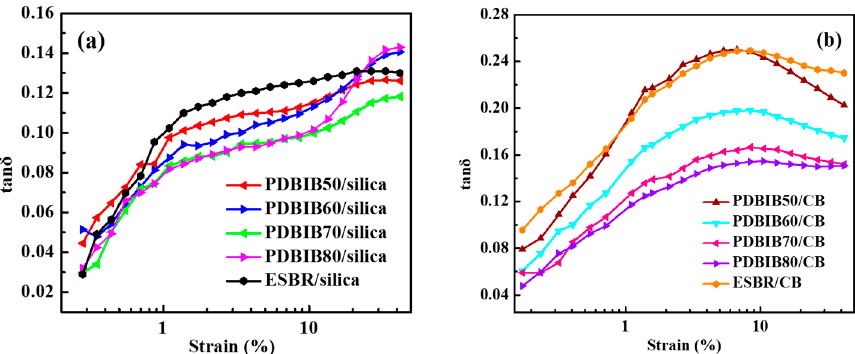
Figure 8. Strain dependence of loss tangent (tan δ ) ( a ) PDBIB / silica and ESBR / silica, ( b ) PDBIB / CB and ESBR / CB compounds.